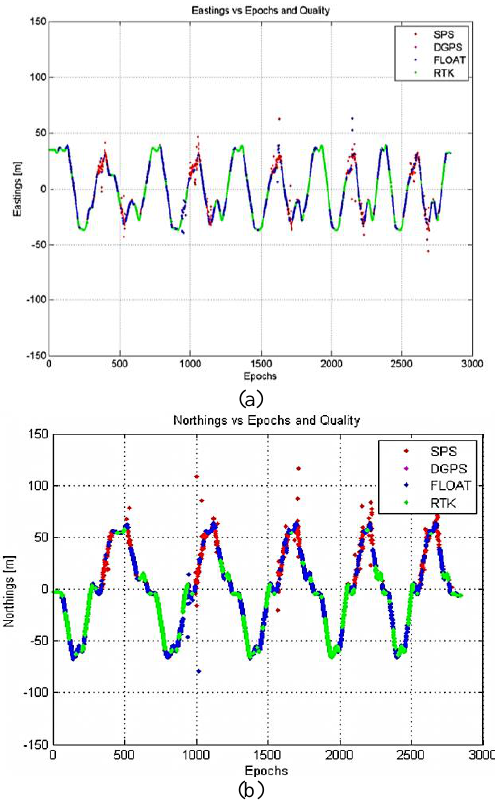
Figure 3. Javad Mobile Kinematic Results: (a) Easting Time Series; (b) Northing Time Series.